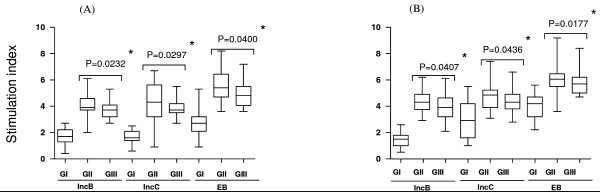
MTT assay showing proliferative responses. Proliferative responses (stimulation indices) of (A) cervical cells and (B) PBMCs isolated from GI, GII, GIII on stimulation with IncB, IncC and CT EB were estimated by MTT assay. (A) *Significant difference in proliferative responses in GII with respect to GIII (P = 0.0232, P = 0.0297 and P = 0.0400 upon stimulation with IncB, IncC and EB respectively). (B) *Significant difference in proliferative responses in GII with respect to GIII (P = 0.0407, P = 0.0436 and P = 0.0177 upon stimulation with IncB, IncC and CT EBs respectively) where; Group I (GI) comprised of healthy fertile women with no CT infection, Group II (GII) comprised of CT-positive fertile women, Group III (GIII) comprised of CT-positive women with fertility disorders. The horizontal line in the middle of the box is the median value of the responses and the lower (upper) is the 25th (75th) percentile., *Significant; PBMCs- Peripheral blood mononuclear cells; IncB- CT Inclusion membrane protein B; IncC- CT Inclusion membrane protein C; CT- Chlamydia trachomatis; EB- Elementary Bodies; n- Number. Proliferative responses between groups were evaluated using Mann-Whitney U test.